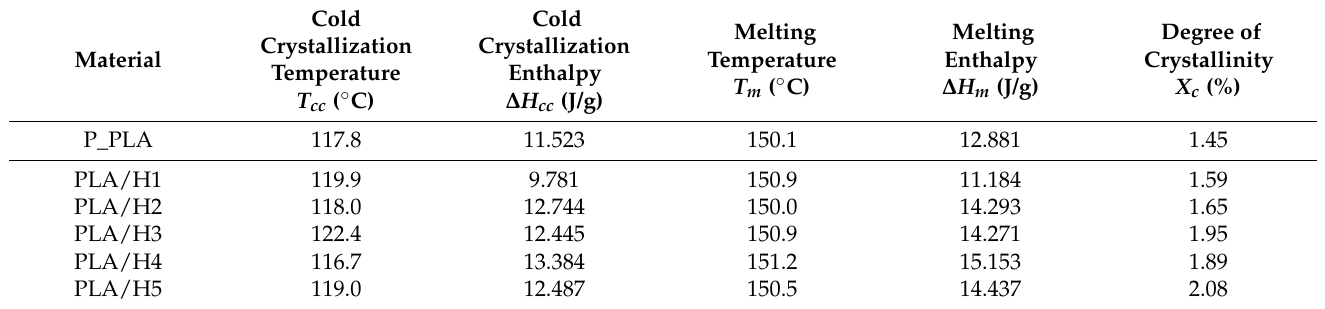
Figure 6. DSC heating curves of 3D printed PLA and NFRC specimens. Table 3. Thermal properties and degree of crystallinity of 3D printed PLA and NFRCs.